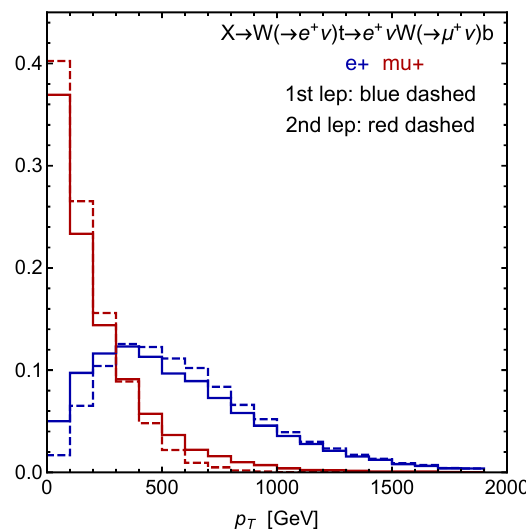
Figure 9 . Parton level shape of the transverse momentum distribution normalised to unit area of the electron and muon compared to the ones of the leading and subleading leptons in the process pp ! X (cid:22) X with X ! W + ( ! e + (cid:23) e ) t and t ! W + ( ! (cid:22) + (cid:23) (cid:22) ) b , with m X = 2500 GeV and p s = 33 TeV.